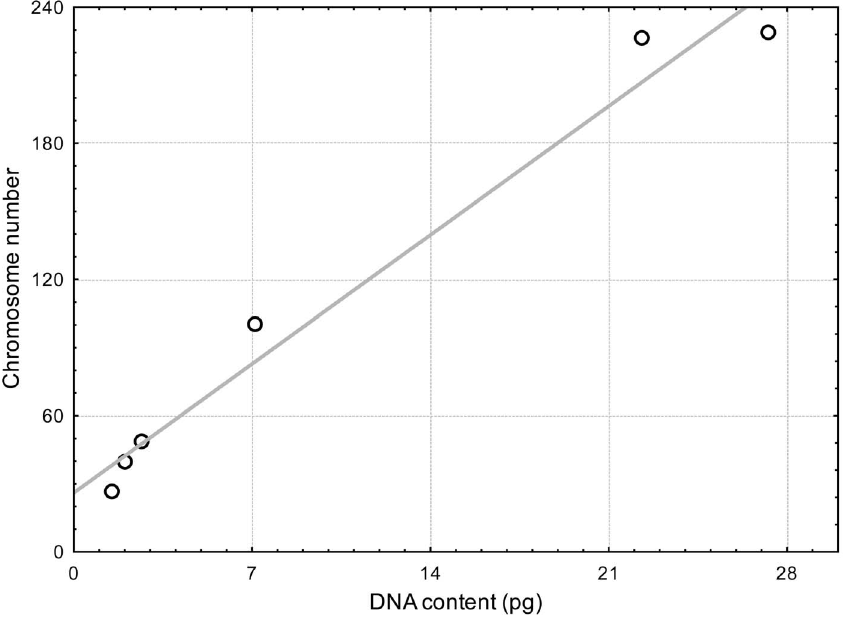
Figure 3. Linear regression of measured DNA content on the chromosome data in six Micrasterias strains. Chromosome data published by Kasprik [44], (r=0.987, R 2 =0.974, P-value , 0.001).